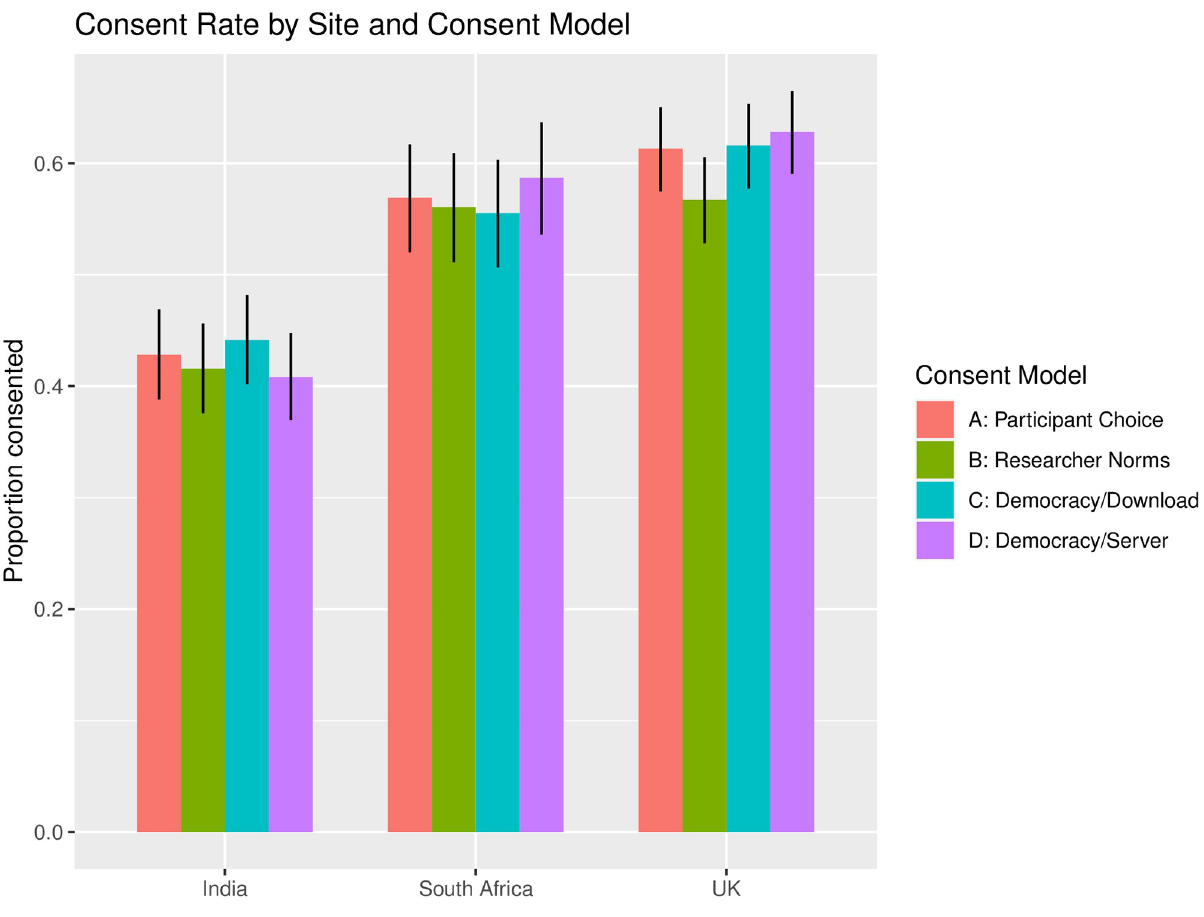
Fig 5. Consent rate by country and consent